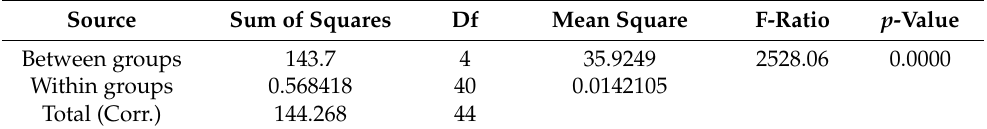
Table 6. ANOVA analysis.